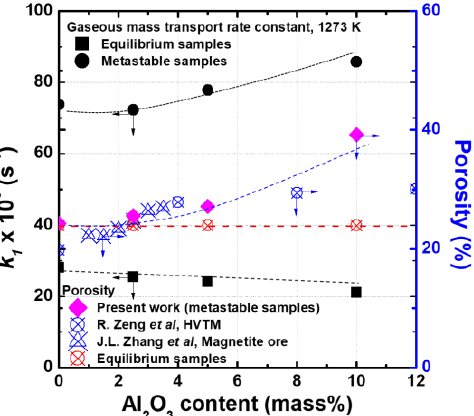
Figure 10. Variation of apparent GMT rate constant and sinter porosity with Al 2 O 3 content.